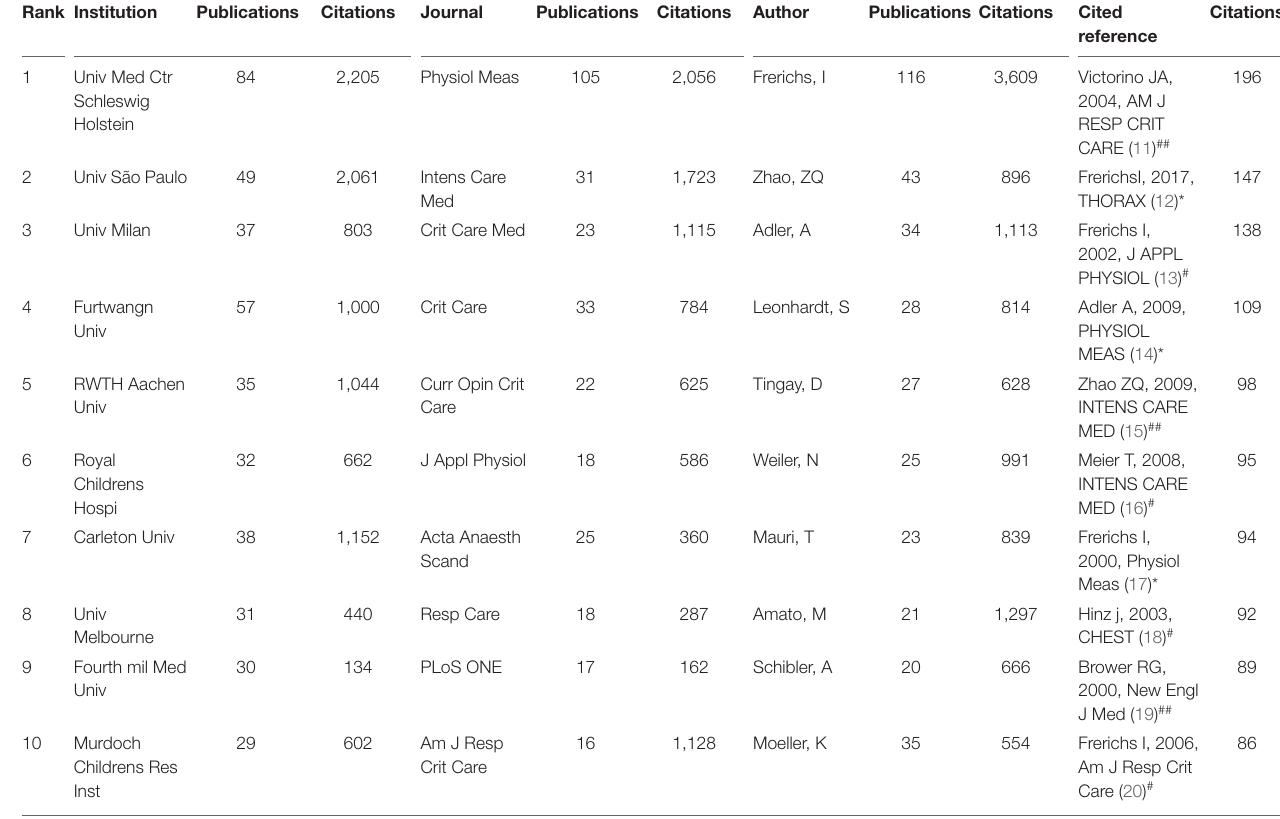
TABLE 1 | The top 10 institutions, journals, authors of publications, and reference articles on electrical impedance tomography (EIT) lung